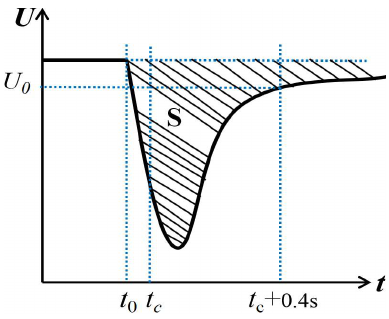
Figure 3. Schematic diagram of voltage sag area. Table 2. Calculation results of voltage sa g area under different conditions. Table 2. Calculation results of voltage sag area under different